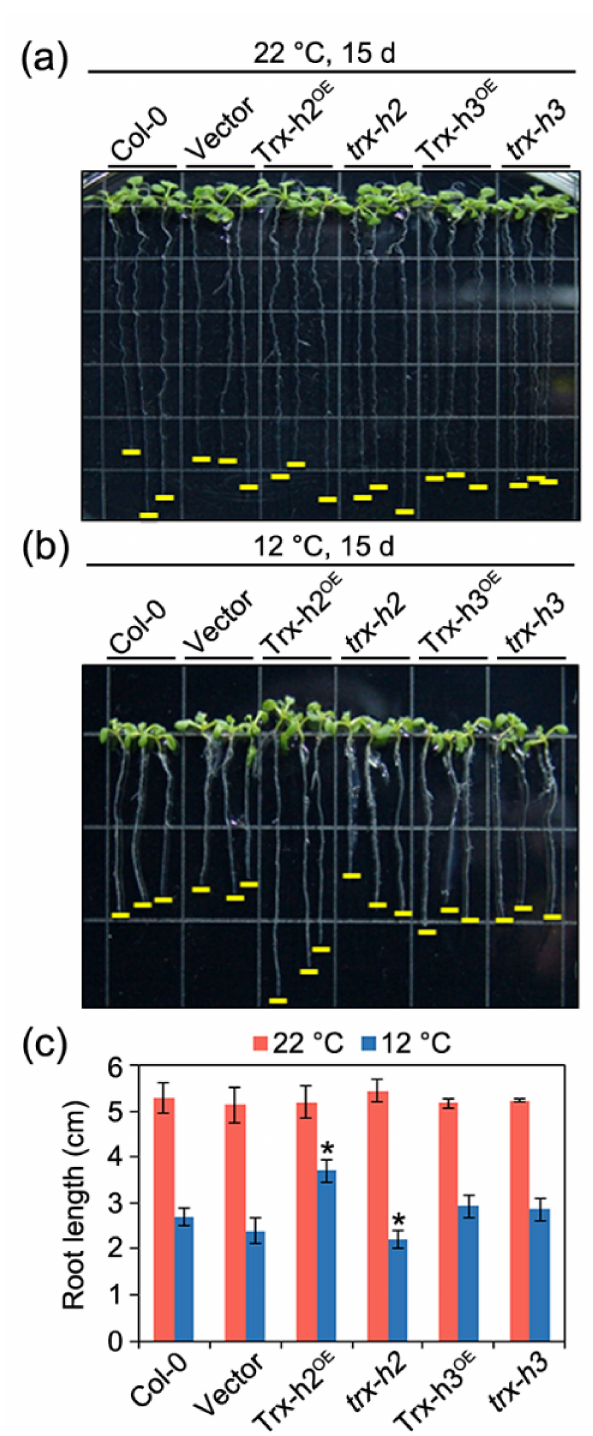
Figure 3. Trx-h2 increases the root growth of Arabidopsis seedlings under cold condition. ( a , b ) Com- parison of the root growth of WT (Col-0), trx-h2 knockout mutant, and Trx-h2 overexpression ( Trx- h2 OE ) plants at 22 ◦ C ( a ) and 12 ◦ C ( b ). Plants expressing Trx-h3 or pCAMBIA1300 vector were used as controls. Arabidopsis seedlings were grown on Murashige and Skoog (MS) medium at different temperatures for 15 days. Plates were oriented vertically and photographed. ( c ) root length of various genotypes at different temperatures. Data represent mean ± standard error (SE) of three biological replicates. Significant differences between the WT (Col-0) and other genotypes ( n = 4) are indicated by an asterisk (* p < 0.05; Student’s t